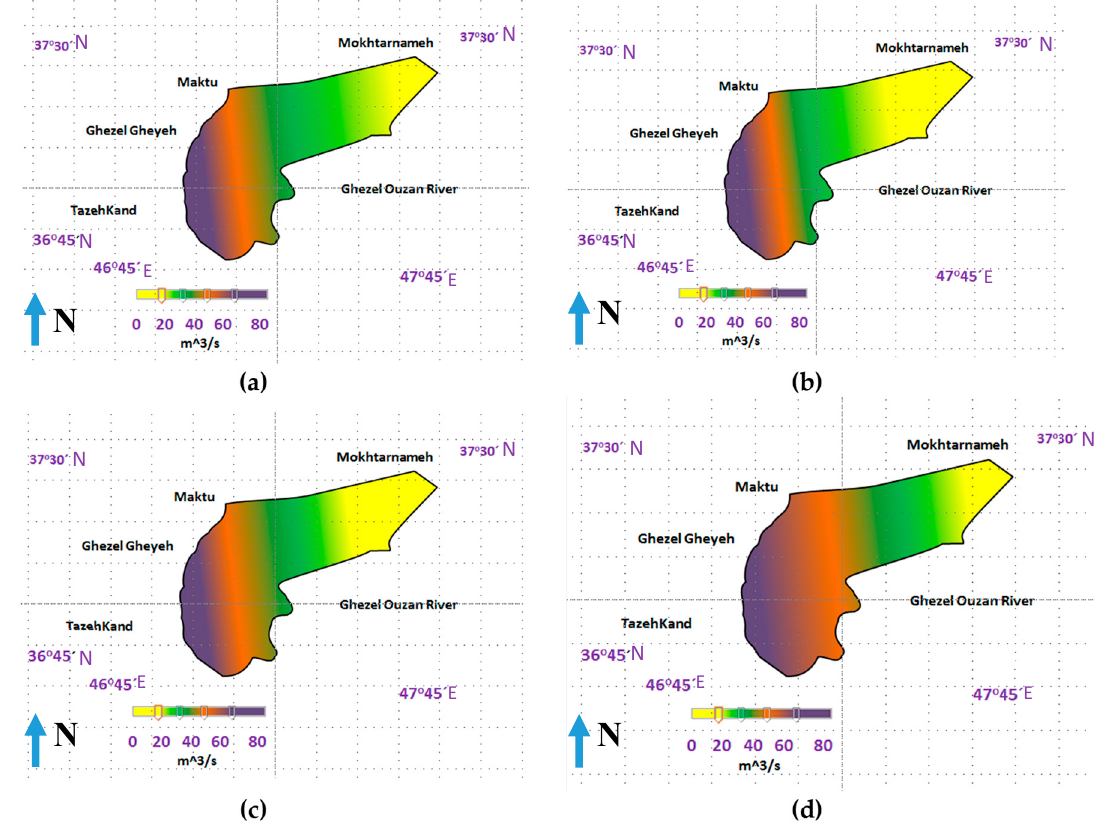
Figure 8. ( a ) spatial streamflow based on ANIFS-BA, ( b ) observed spatial streamflow based on ANFIS-PSO, ( c ) spatial streamflow based on ANFIS-GA, ( d ) spatial streamflow based on observed map.